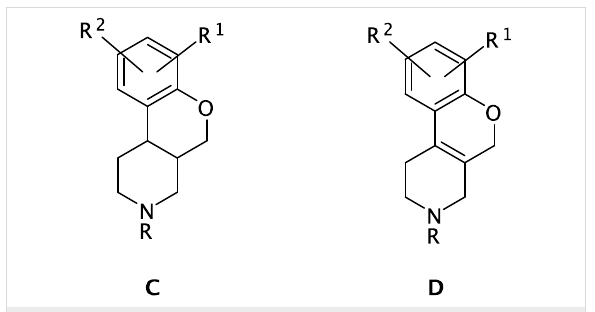
Figure 2: General structures C & D , Benzopyrano pyridine